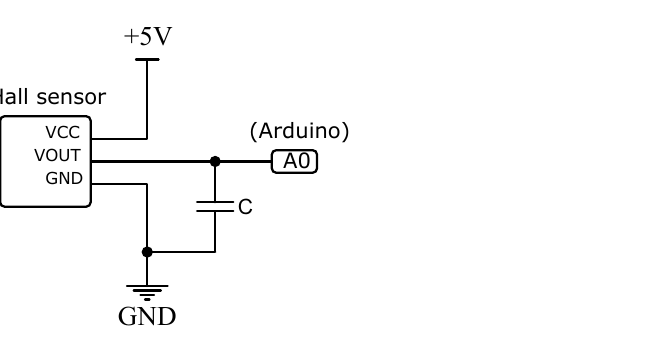
Figure 5. Hall-effect sensor circuit. The sensor is connected to the analog input of the Arduino Uno through PIN A0. The capacitor C = 10 µ F was included in the filter noise.